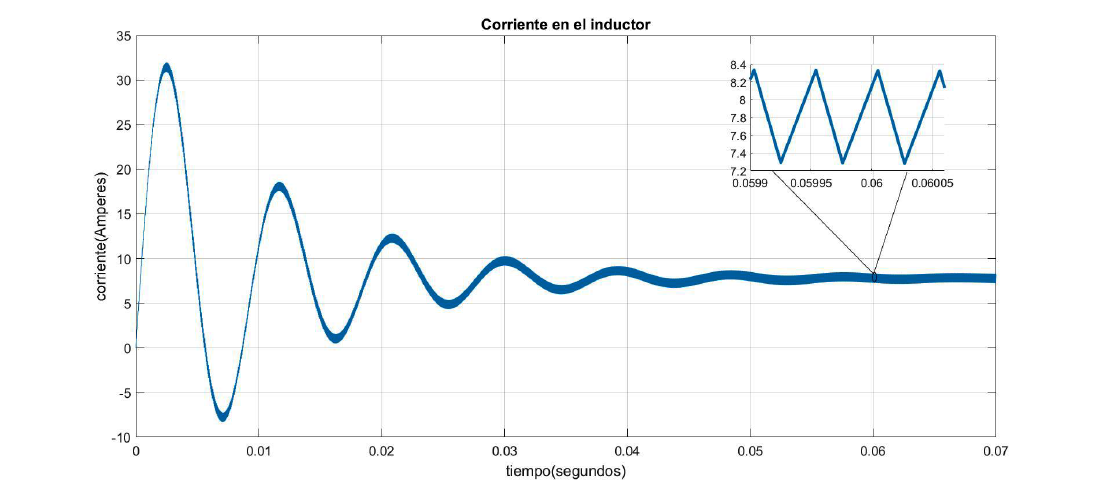
Figure 8. Inductor current in the Buck-Boost switching